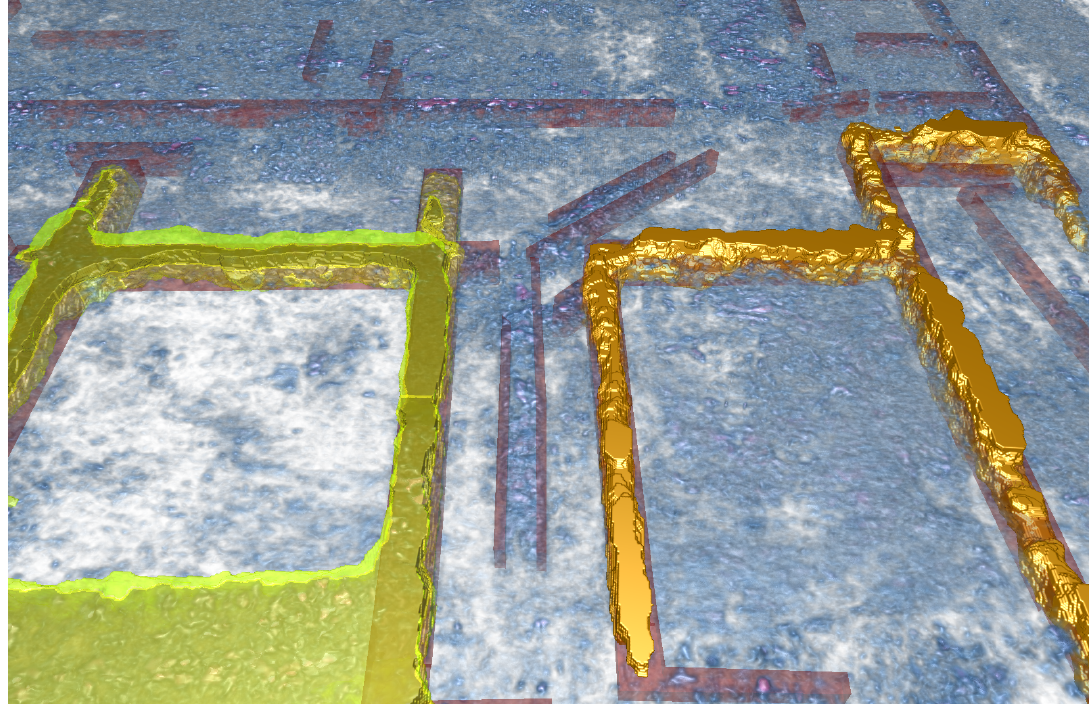
Figure 11. Combined visualization of original GPR dataset (DVR) using the same transfer function as in Figure 4 (blue), mesh representation of an interpretation model (red) obtained by extruding polygons drawn on top of 2D GPR slices, and the result from interactive 3D segmentation of the walls of two buildings (yellow and orange). The segmentation datasets are more detailed, reflecting the actual shape of the walls, while the hand drawn interpretation shows an idealized floor